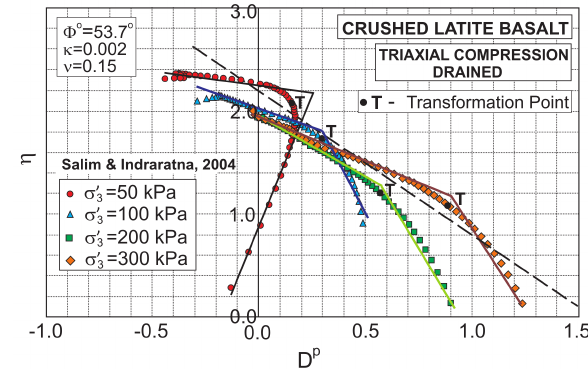
Figure 3: The relationships between stress ratio, volume deformations and shear strain: (a) q εσσ − )( (adopted from Salim and Indraratna, 2004).